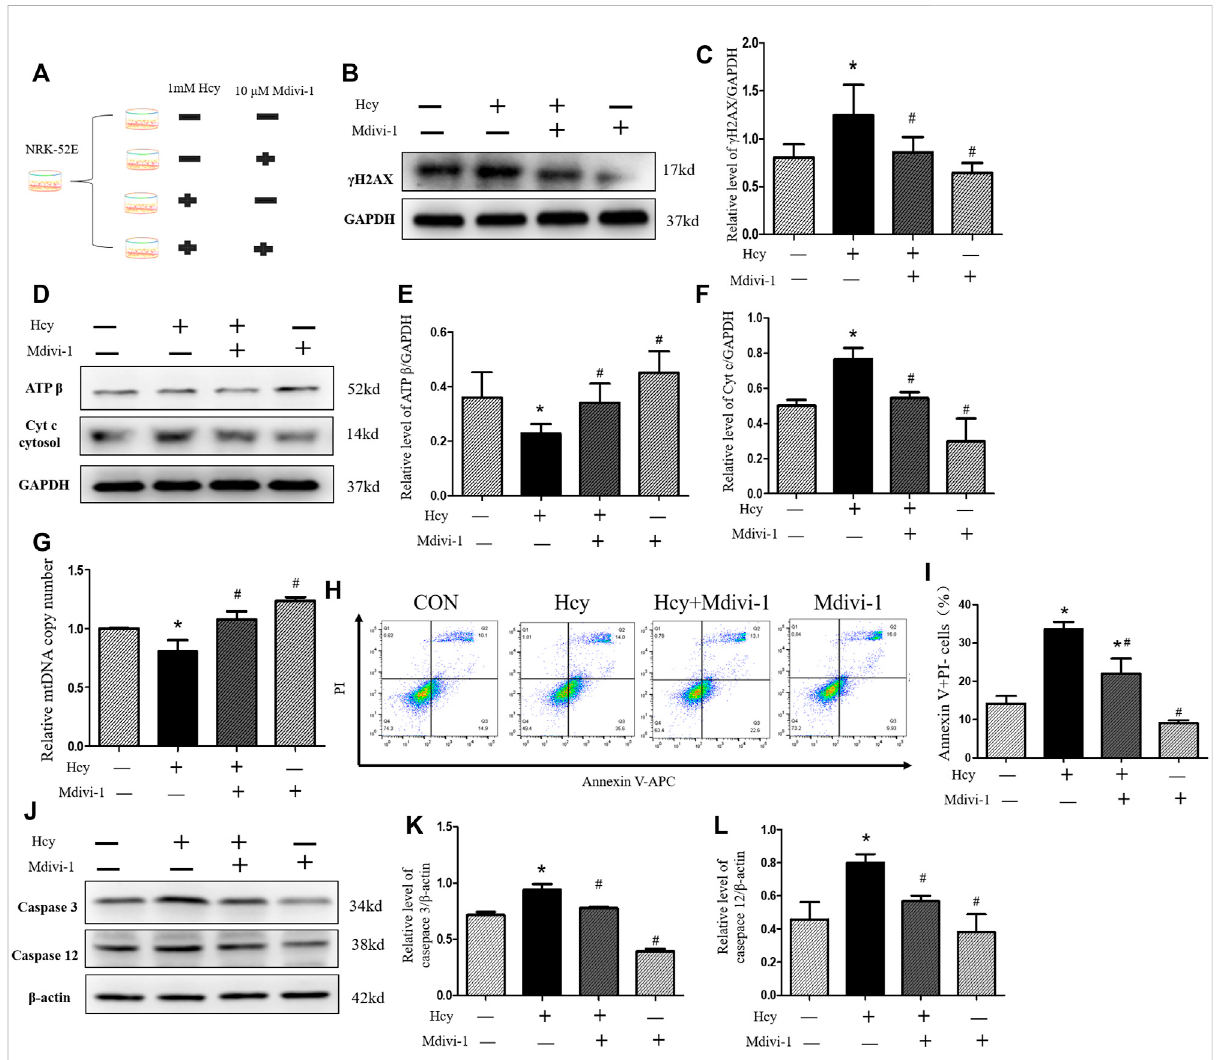
FIGURE 5 Amelioration by Mdivi-1 of HHcy-induced mitochondrial damage in vitro . (A) Mdivi-1 intervention: NRK-52E cells were treated with 1 mM of homocysteine with or without 10 µM Mdivi-1 for 16 h (B , D) Representative western blots show the levels of γ H2AX, ATP β , and Cyt C after Mdivi-1 intervention in NRK-52E cells. (C , E , F) Relative levels of: (C) γ H2AX; (E) ATP β ; and (F) Cyt C after Mdivi-1 intervention in NRK-52E cells. (G) Real-time PCRshowsmtDNAcopynumber. (H) FlowcytometryassaysshowcellapoptosisinNRK-52EcellsafterMdivi-1interventioninNRK-52Ecells. (I) Percentage of apoptotic cells. (J) Representative western blots show the levels of caspase 3 and caspase 12 after Mdivi-1 intervention in NRK-52E cells. (K , L) Relative levels of: (K) caspase 3; (L) caspase 12 after Mdivi-1 intervention in NRK-52E cells. Data expressed as mean ± SD, n = 3 per group. * p < 0.05 versus control group; # p < 0.05 versus cells treated with